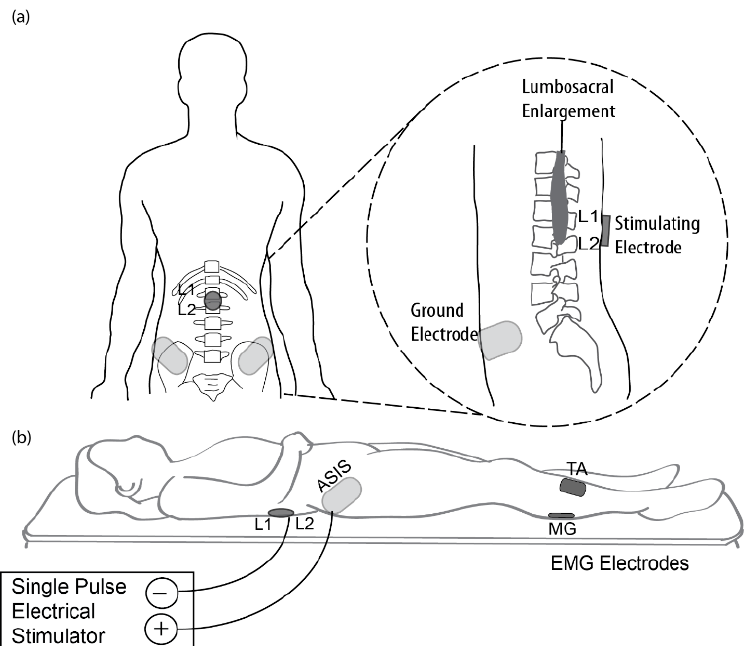
Figure 1. Transcutaneous electrical spinal cord stimulation (tSCS) setup. ( a ) Sketch of the placement of stimulating and reference electrodes between L1 and L2 spinous processes and the anterior superior iliac spine (ASIS), respectively, relative to the lumbosacral enlargement. ( b ) Experiment setup of single-pulse tSCS showing the posture of the participants, positions of anode and cathode electrodes, and electromyographic (EMG) recordings from tibialis anterior (TA) and medial gastrocnemius (MG) muscles.